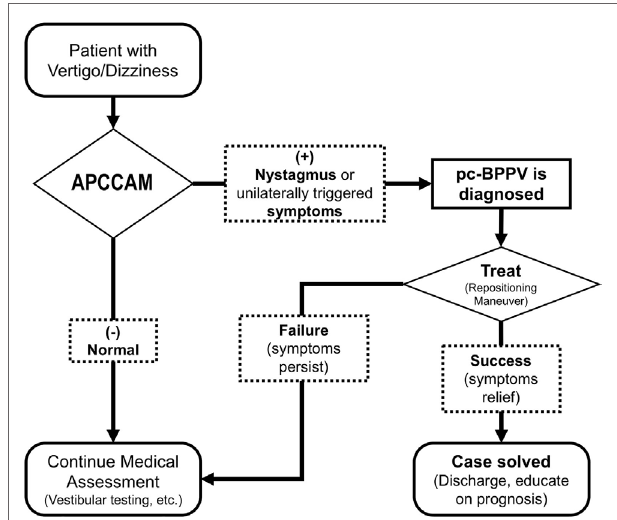
FigUre 6 | conceptual algorithm emphasizing the potential role of the aPccaM . Because it is the most frequent specific cause of vertigo, identifying pc-BPPV using the APCCAM may lead to instant treatment, thereby avoiding unnecessary referrals or